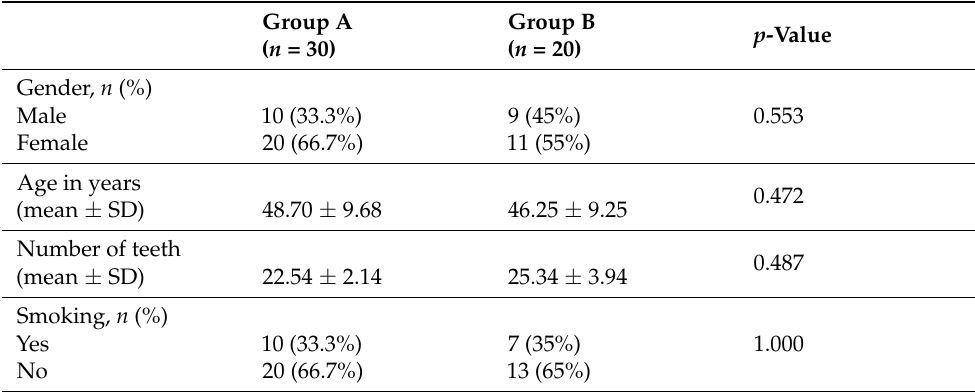
Table 1. Patients’ demographic characteristics.